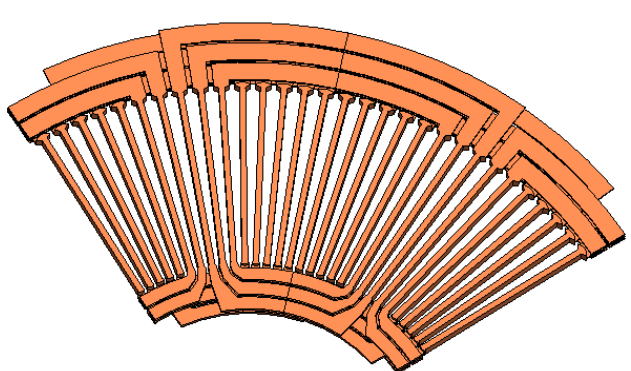
Figure 5. Solving domain model of stator of the prototype.